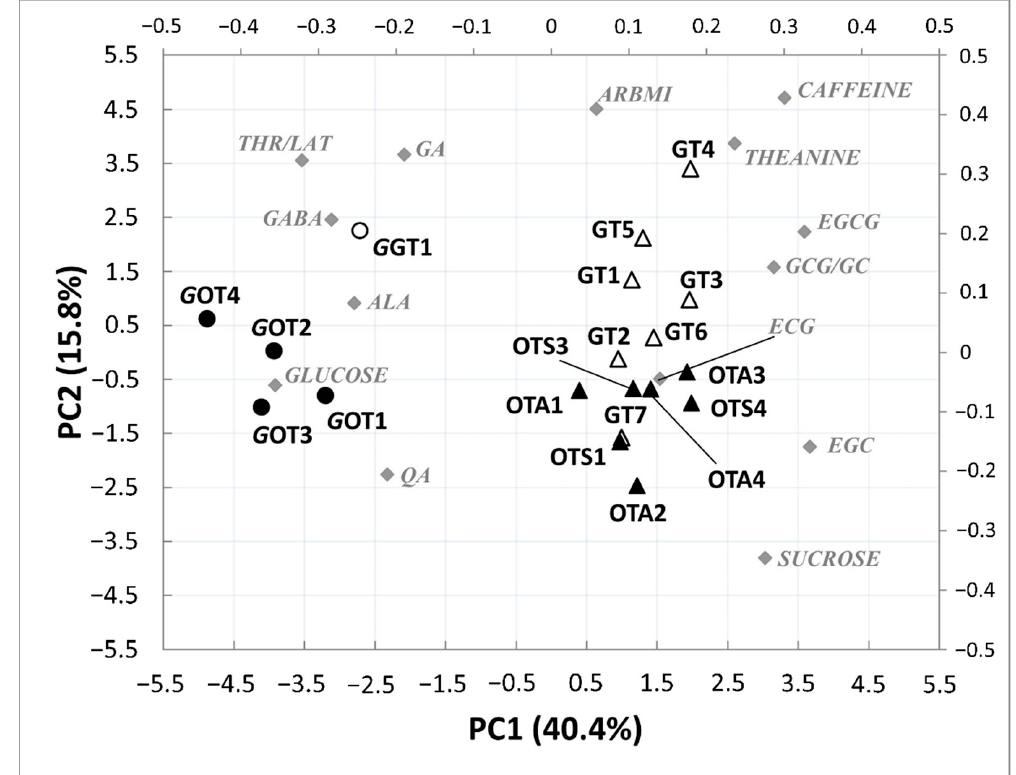
Figure 2. Biplot diagram of PCA performed using 14 resonances measured in the 1 H NMR spectra of 19 tea samples belonging to four different types of tea (unfilled triangles = green teas; unfilled circles = GABA green teas; filled triangles = oolong teas; filled circles = GABA oolong teas).